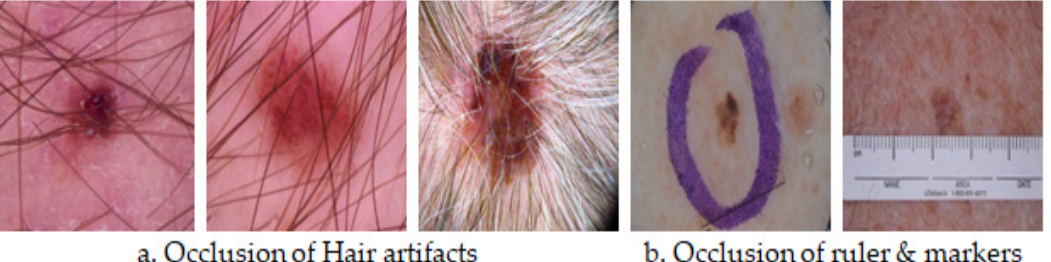
Figure 6. Artefact occlusion samples from the dataset are misclassified. ( a ) Occlusion of hair artifacts and ( b ) Occlusion of ruler & markers